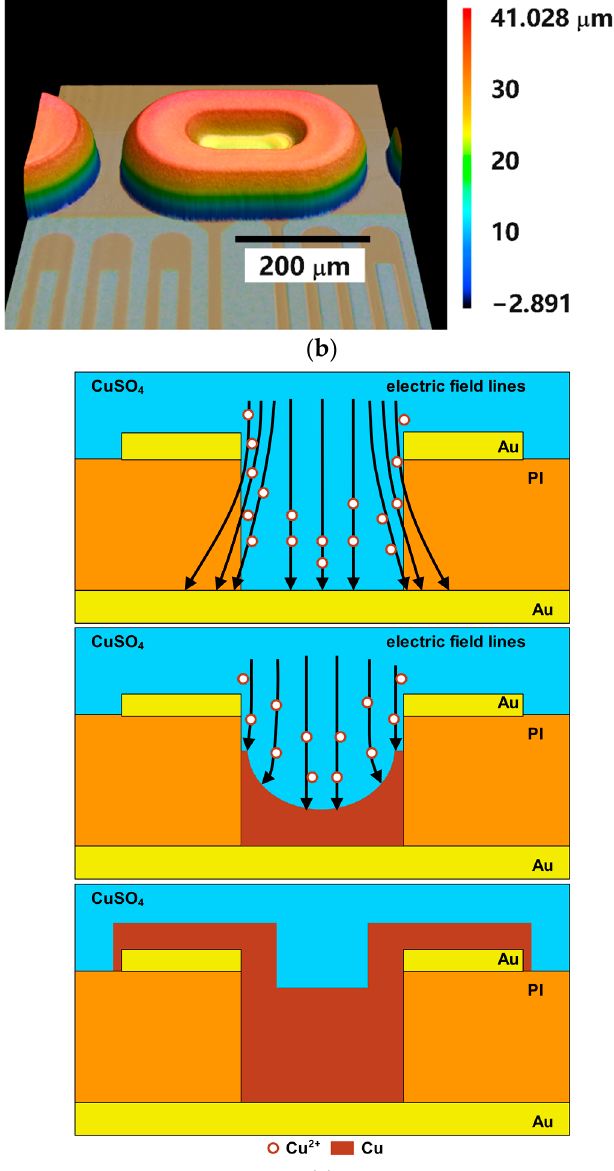
Figure 5. 3D shape of the copper surface of contact pads ( a ) and filled micro-vias ( b ) as obtained by confocal laser scanning microscopy (VKX-260 from Keyence). ( c ) Schematic sketch illustrating the development of field lines and ion drifts during the electroplating of micro-vias and the result in shape of the copper filling.